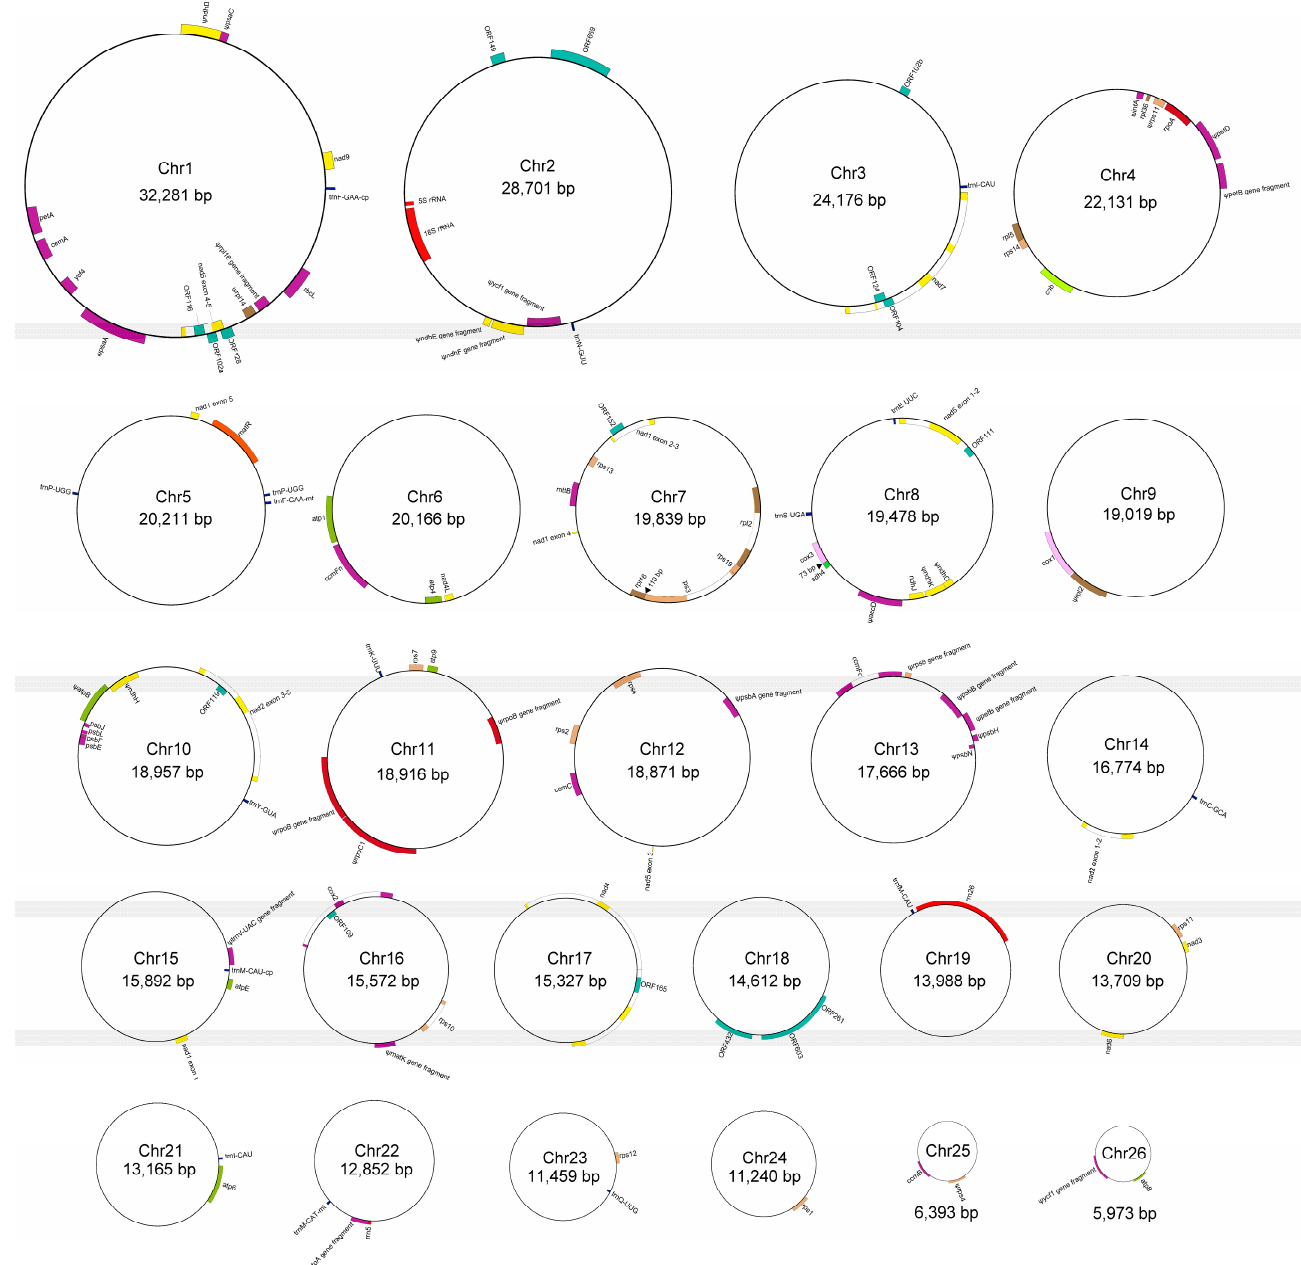
Figure 1. Map of the Paphiopedilum micranthum mitogenome. The genome consisted of 26 circular chromosomes. Genes drawn inside and outside each circle are transcribed clockwise and counter- clockwise. Two triangles show the positions of the overlapping of cox3 - sdh4 and rpl16 - rps3 , with the length of overlap indicated.